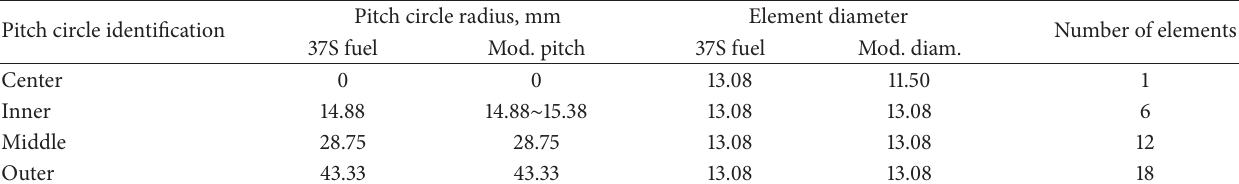
Table 1: Geometries of the modifications of standard 37-element fuel.